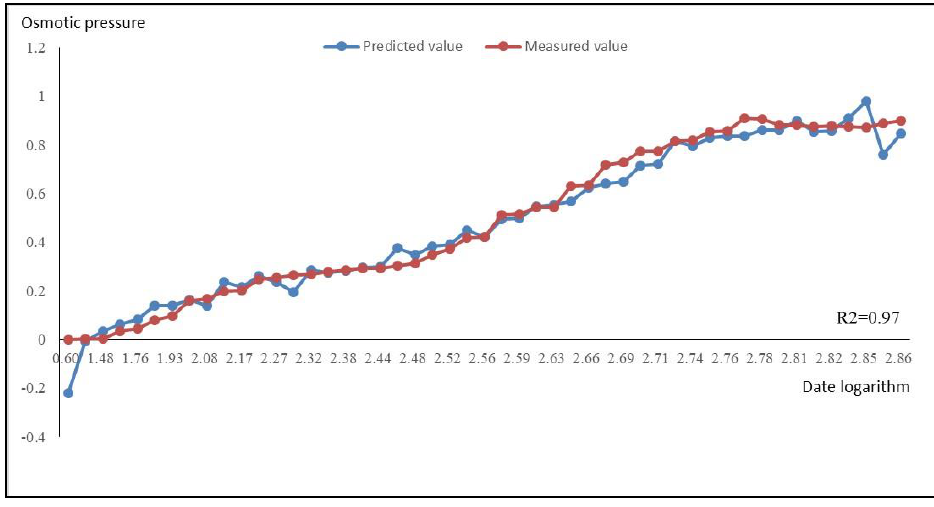
Figure 9. Osmotic Pressure Measured and Predicted Value Process Chart during Construction Period.